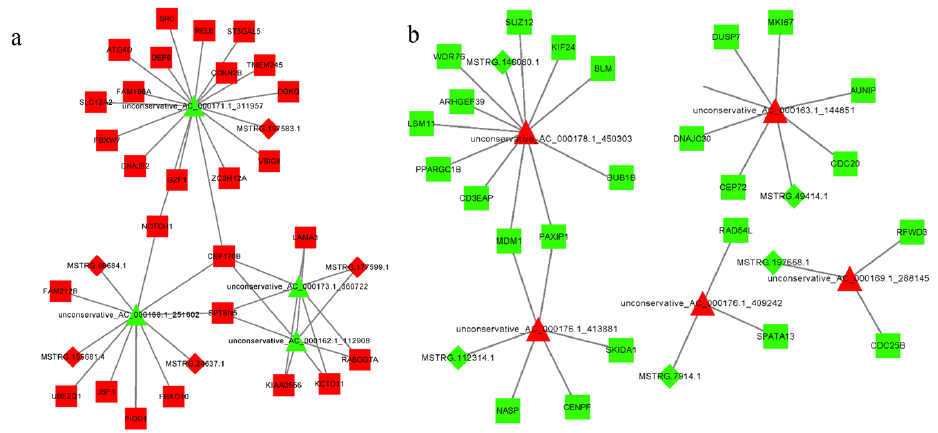
Figure 7. Construction of the lncRNA–miRNA–mRNA ceRNA regulatory network. ( a , b ) lncRNA–miRNA–mRNA ceRNA regulatory network. The diamonds represent lncRNAs, the triangles represent miRNAs, the squares represent mRNAs, red indicates upregulation, and green indicates downregulation.